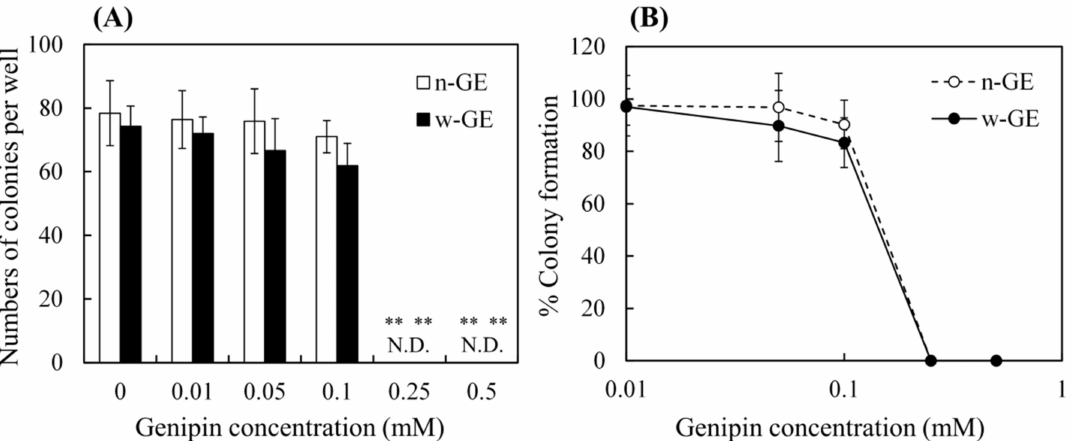
Figure 5. Results of cumulative cytotoxicity tests for w-GE and n-GE by a colony counting method. In these assays, colonies of V79 cells were counted after 7 days of culture. The bar graph ( A ) shows the number of colonies, in which statistical analyses were performed to evaluate statistical significance between various concentrations of genipins (0.02–5 mM) and the control (without genipin): **, p < 0.01. On the other hand, statistical analyses in the line graph ( B ) were performed to evaluate statistical significance between w-GE and n-GE at similar concentrations. There were no statistical differences between the two groups. Data are presented as mean ± SD ( n =